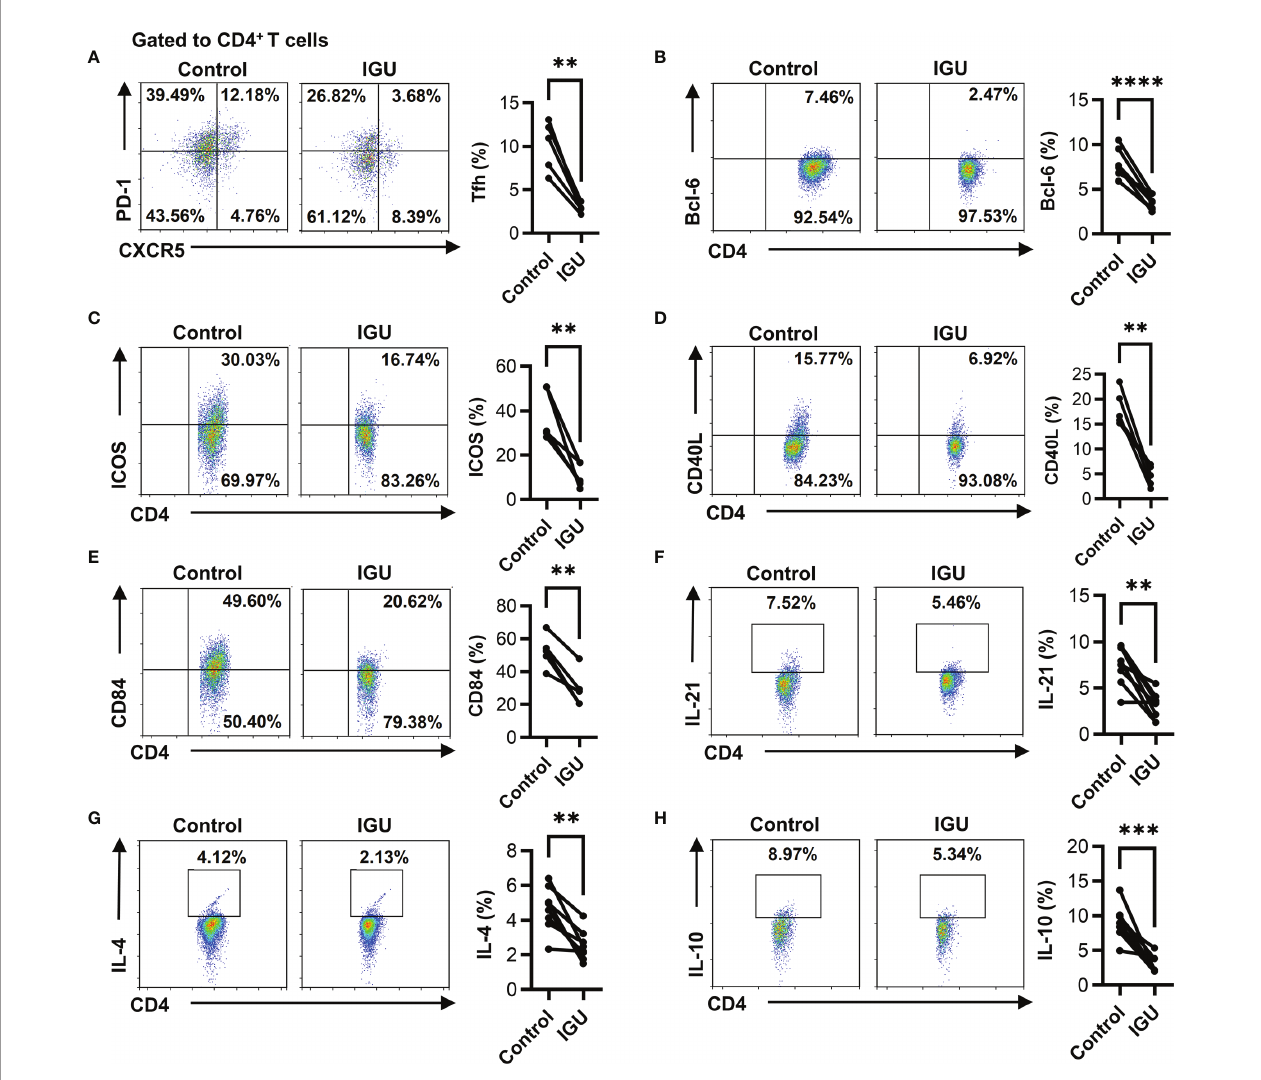
FIGURE 3 | IGU inhibits the cTfh cell function of RA patients. RA PBMCs activated by anti-CD3/CD28 antibody (2 m g/ml) were cultured with IGU or DMSO for 72 hours. (A) The percentage of Tfh (CD4 + CXCR5 + PD-1 + T) cells was measured by fl ow cytometry (n = 5). (B) The percentage of CD4 + Bcl-6 + T cells was measured by fl ow cytometry (n = 8). (C – E) The expression of ICOS, CD40L, and CD84 on CD4 + T cells were detected by fl ow cytometry (n = 5). (F – H) The secreted cytokines of CD4 + T cells, including IL-21, IL-4, and IL-10, were measured by fl ow cytometry (n = 8). Symbols represent individual subjects. ** P < 0.01; *** P < 0.001; **** P <